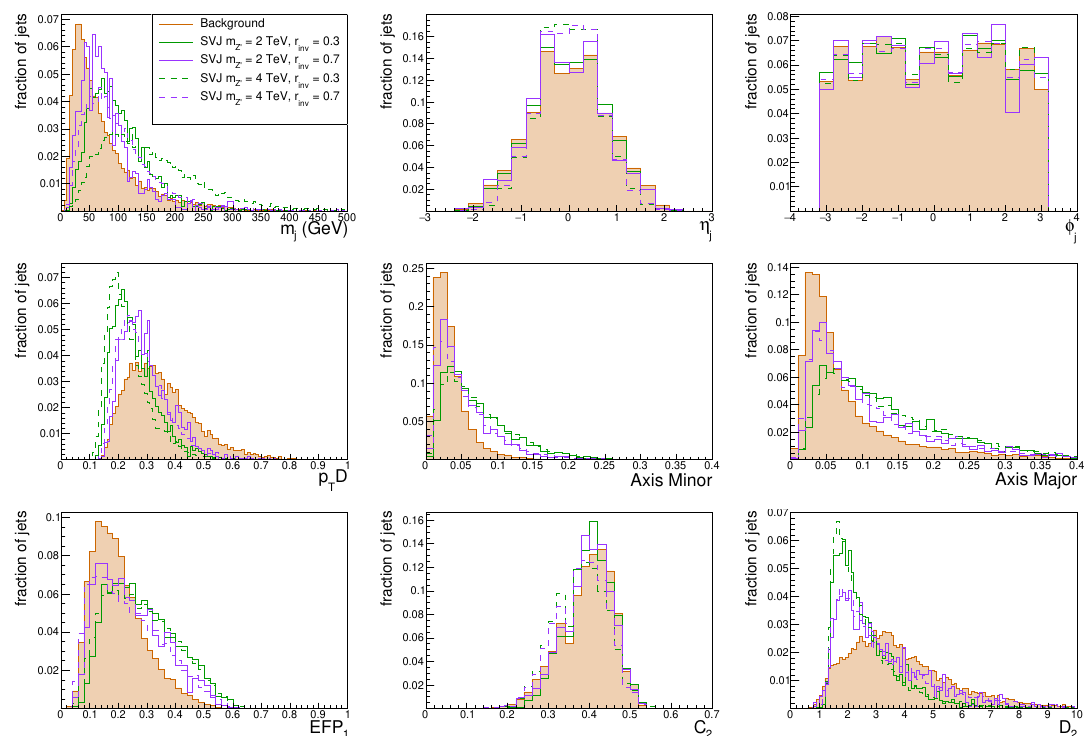
Figure 1. Distributions of input variables for QCD background and selected signal